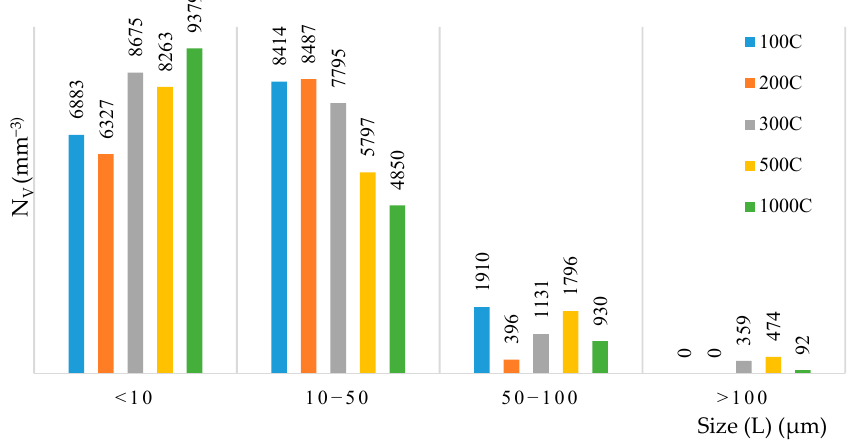
Figure 4. The number of inclusions per volume (N v ) values of sulfides in the 316L steel grade in the different size groups.